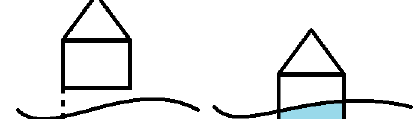
Figure 1. None matching of terrain model with object